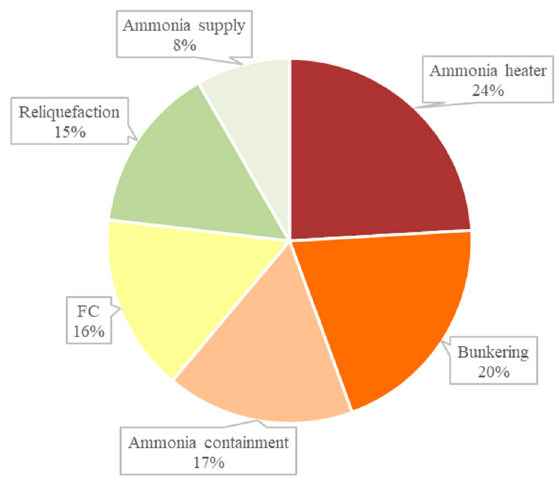
Figure 10. Critical functional failures per system.